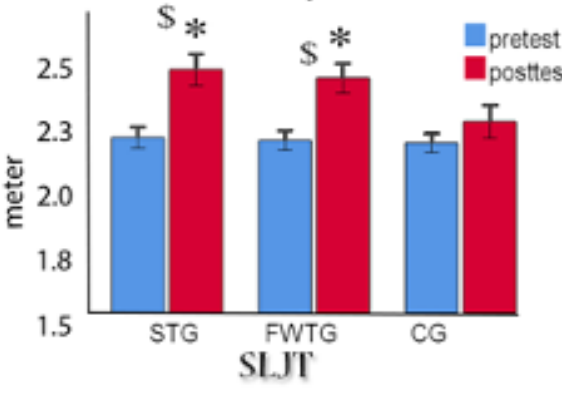
Figure 2. The effects of training intervention on MBTT. *significant difference from pre-test, $ significant difference from the CG.